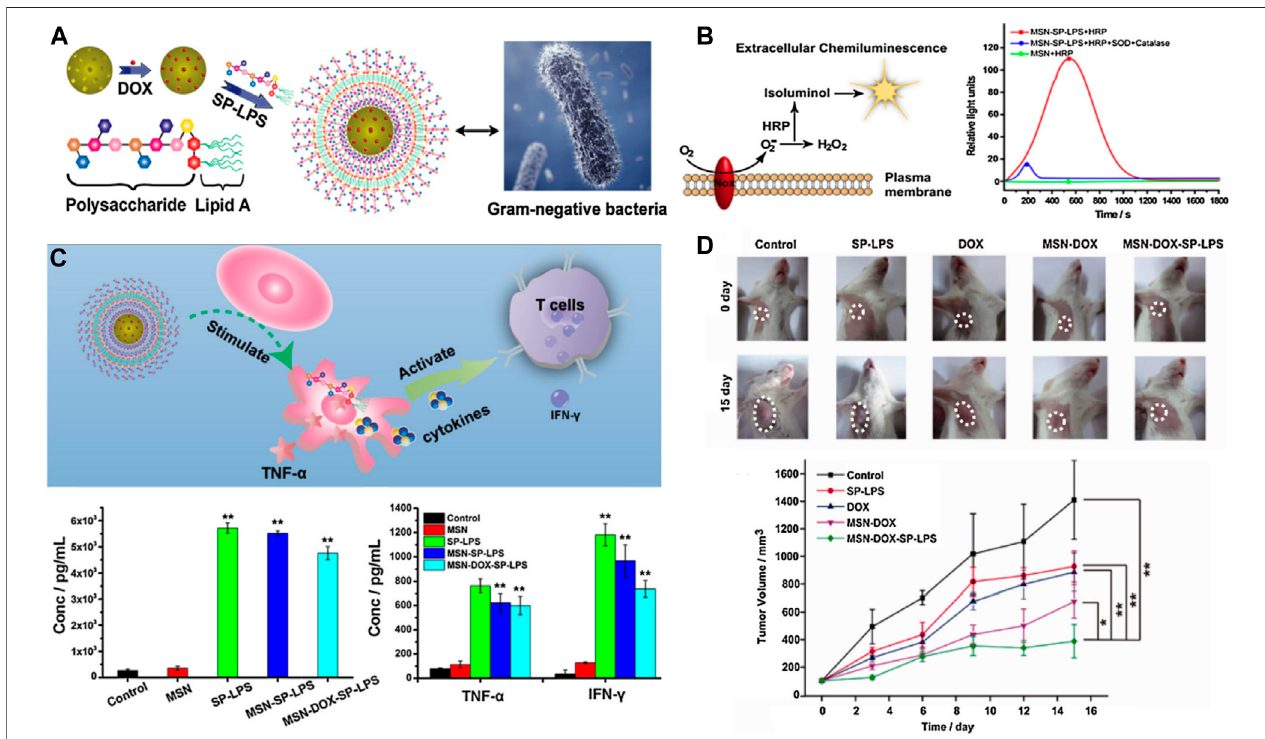
FIGURE12|(A) SchematicillustrationofGram-negativemimickingMSP-DOX-SP-LPS; (B) MSP-SP-LPSstimulatesplenocytestoproduceextracellularROS; (C) Schematic illustration of MSP-DOX-SP-LPS activating macrophages and subsequently stimulating T cells. The picture of tumors after different treatments at 0 and 15th dayandthelocationofthetumorswaslabeledbybrokencircles. (D) Andtherelativetumorvolumesweretreatedwithdifferentsamples.Reprintedwithpermissionfrom Dong et al. (2017). Copyright (2017) Elsevier.